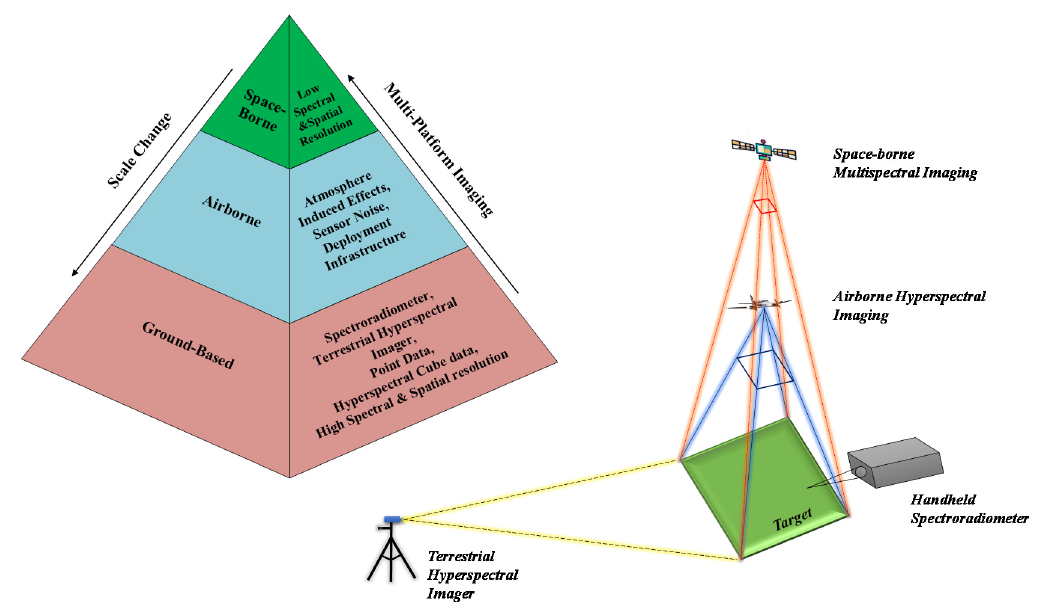
Figure 1. Conceptual design of the experimental set up used for the acquisition of multi-platform remote sensing data.